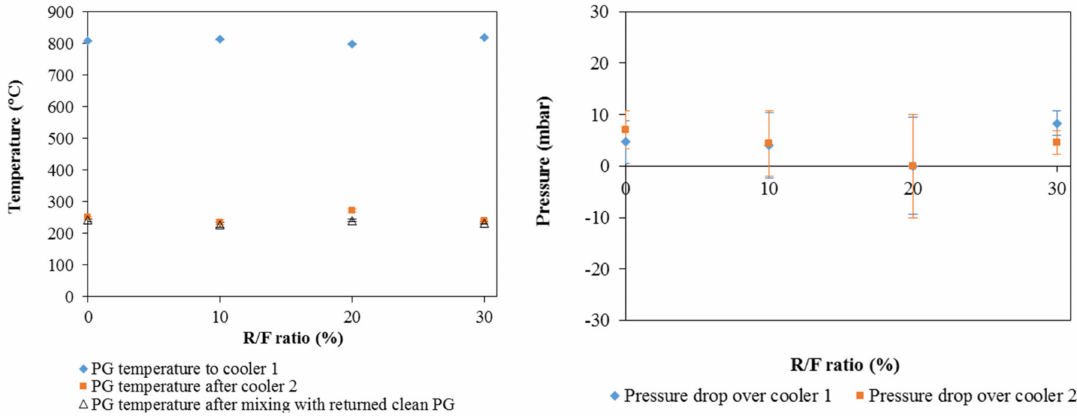
Figure 9. Influence of R/F ratio on the product gas (PG) temperature of the coolers and the pressure drop over the coolers.